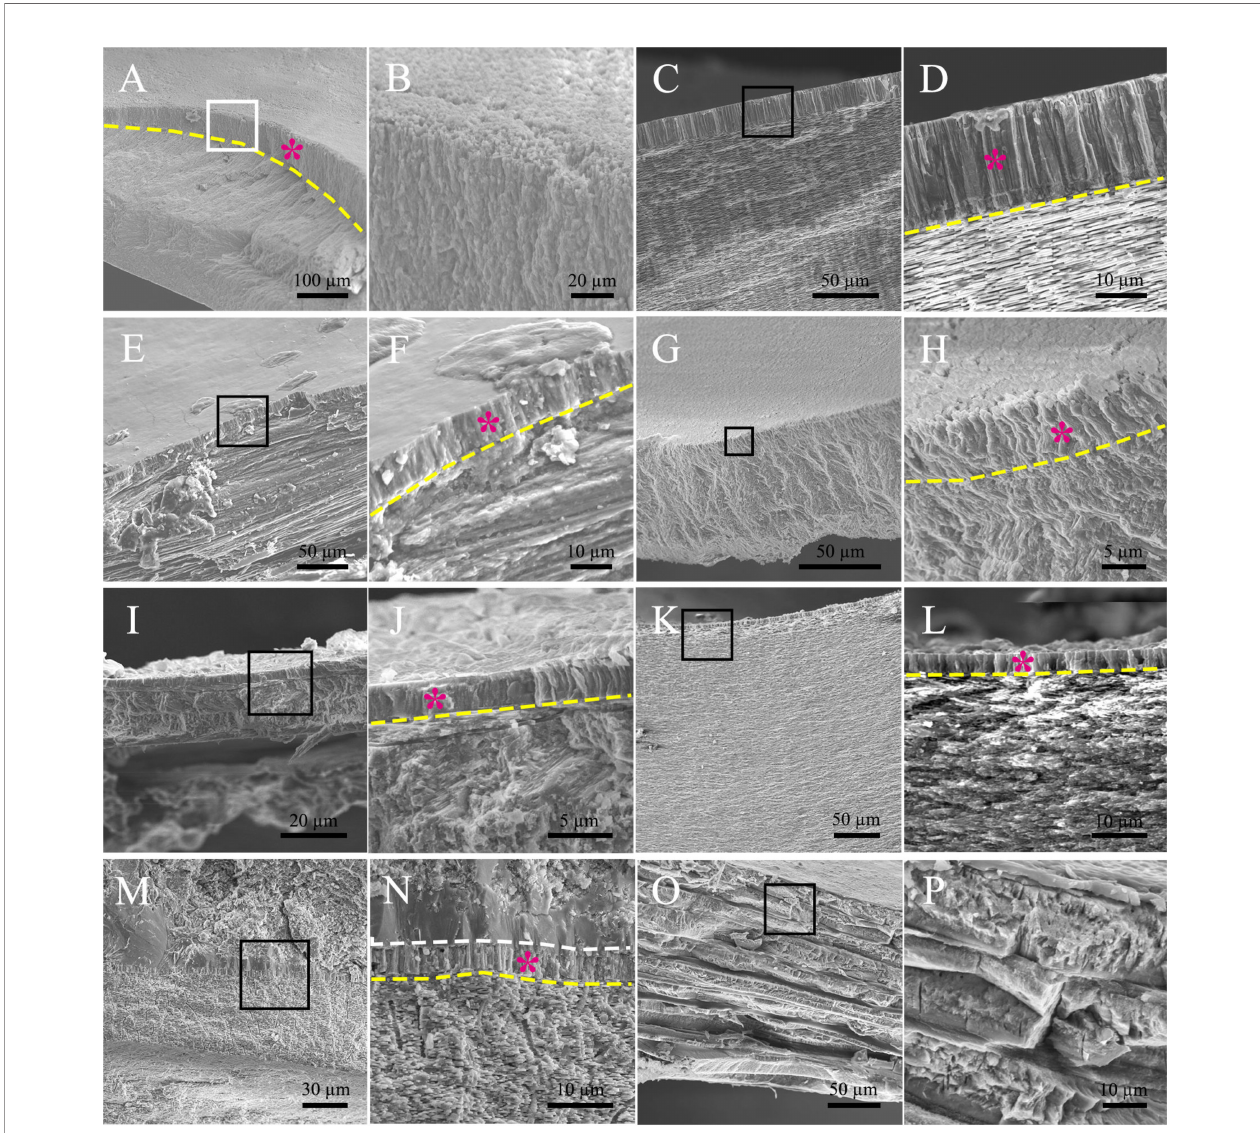
FIGURE 2 | Microstructure of the myostracum layer in some molluscan classes. (A, B) chiton Ischnochiton comptus (Gould); (C, D) abalone Haliotis discus ; (E, F) Limpets Cellana toreuma ; (G, H) mud snail Bullacta exarata (Philippi, 1848); (I, J) fresh water snail Bradybaena ravida (Benson); (K, L) Scaphopoda Pictodentalium vernerdi ; (M, N) Ammonoidea sp.; (O, P) Brachiopod Lingula anatine , serving as a comparison. In each sample examined, the latter image is the magni fi cation of the black box in the former image. The myostracum layer was indicated by a purple star, and the boundary between the myostracum and the underlying shell layers was indicated by the yellow dashed line. The white dashed line in (N) shows the boundary between the myostracum and the fi lled impurities in the shell